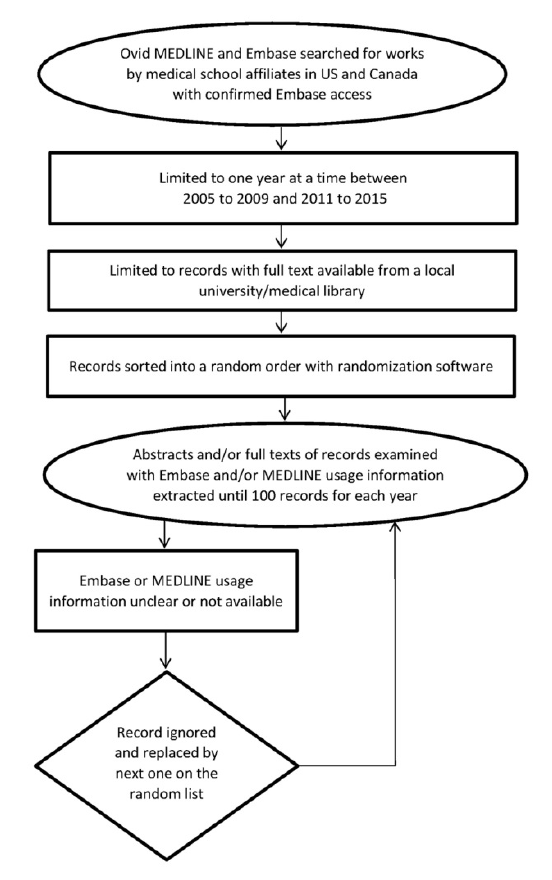
Figure 2 Research process